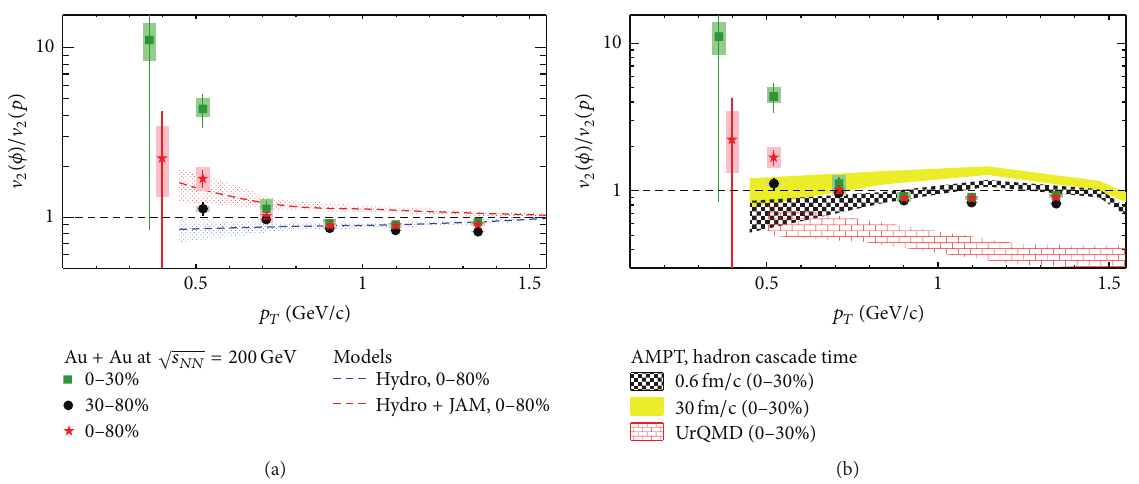
Figure 3: The ratio of V 2 (𝜙) to V 2 (𝑝) as function of 𝑝 𝑇 in Au + Au collisions at √𝑠 𝑁𝑁 = 200 GeV for two centralities, 0–30% and 30–80%. The bands in panels (a) and (b) represent the hydro and transport model calculations for V 2 (𝜙)/ V 2 (𝑝) , respectively